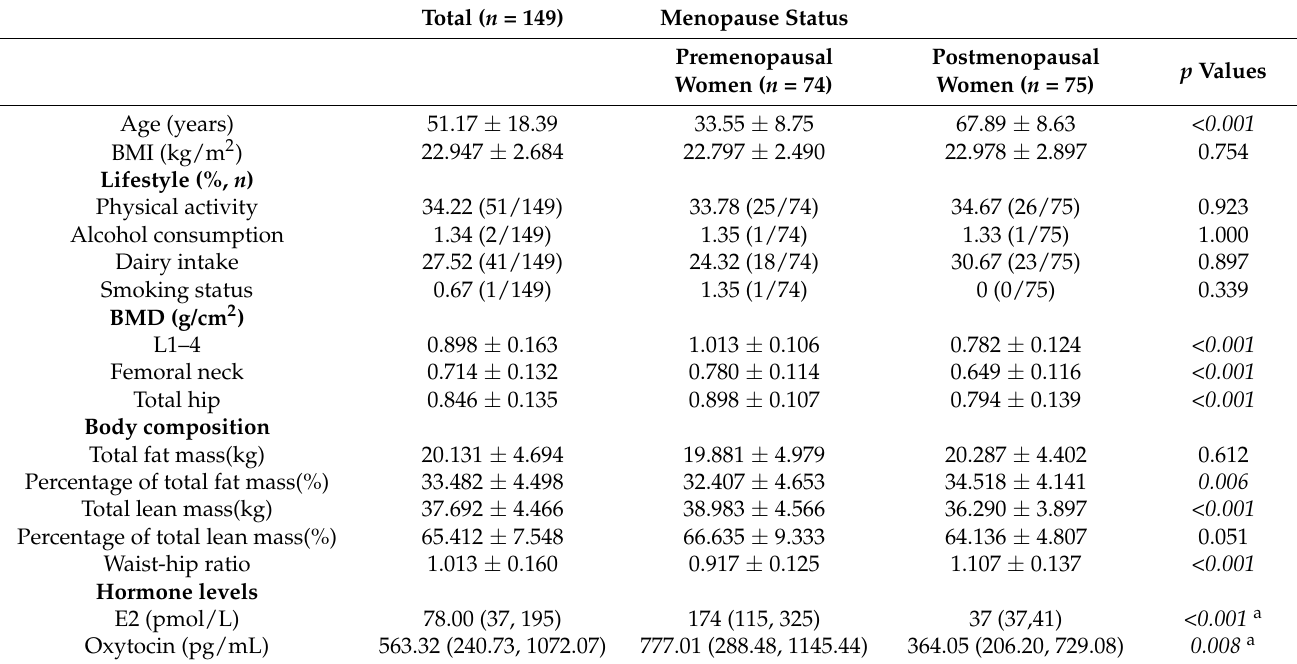
Table 1. Basic characteristics and serum oxytocin levels by menopausal status in Chinese adult